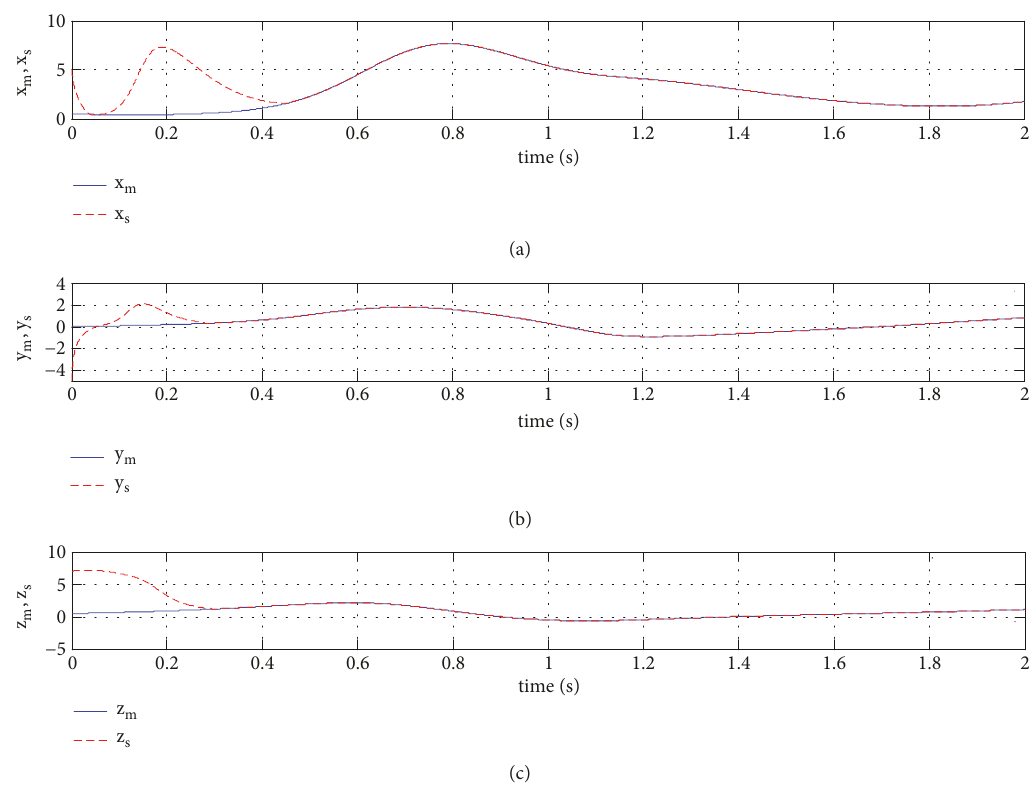
Figure 11: Robust adaptive synchronization process between slave system (58) and master system (3): (a) first state, (b) second state, and (c) third